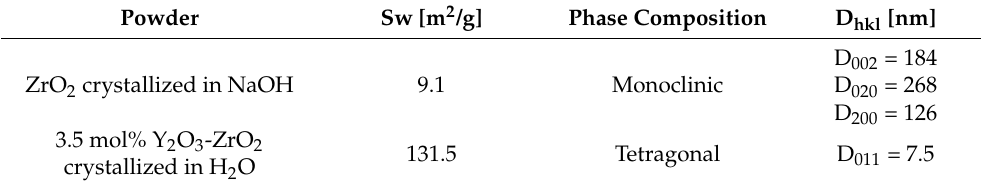
Table 1. Powder characteristics: specific surface area (Sw), phase composition, and crystallite size (D hkl ). Powder Sw [m 2